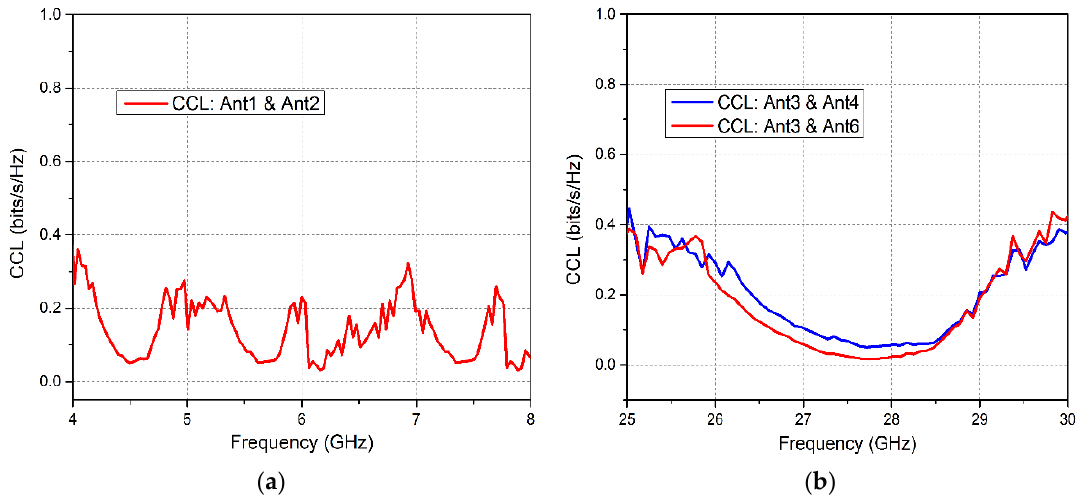
Figure 16. Channel Capacity Loss ( CCL) for ( a ) LTE MIMO Antennas; ( b ) 5G MIMO Antennas.